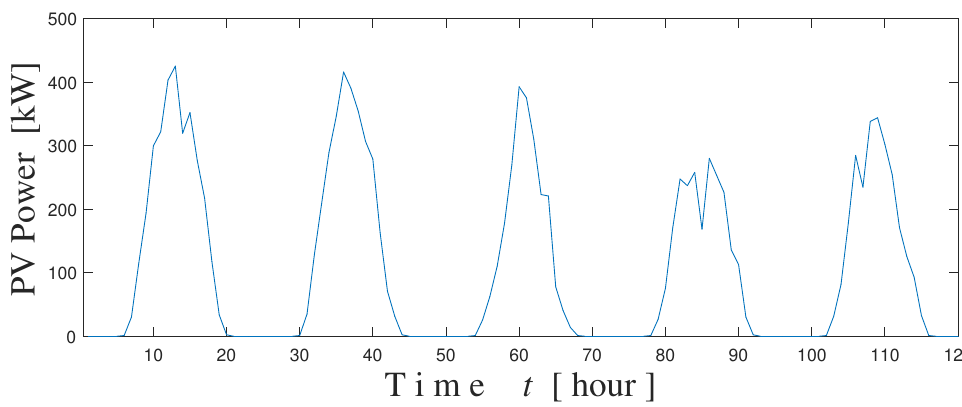
Figure 4. Photovoltaic (PV) power distribution over five